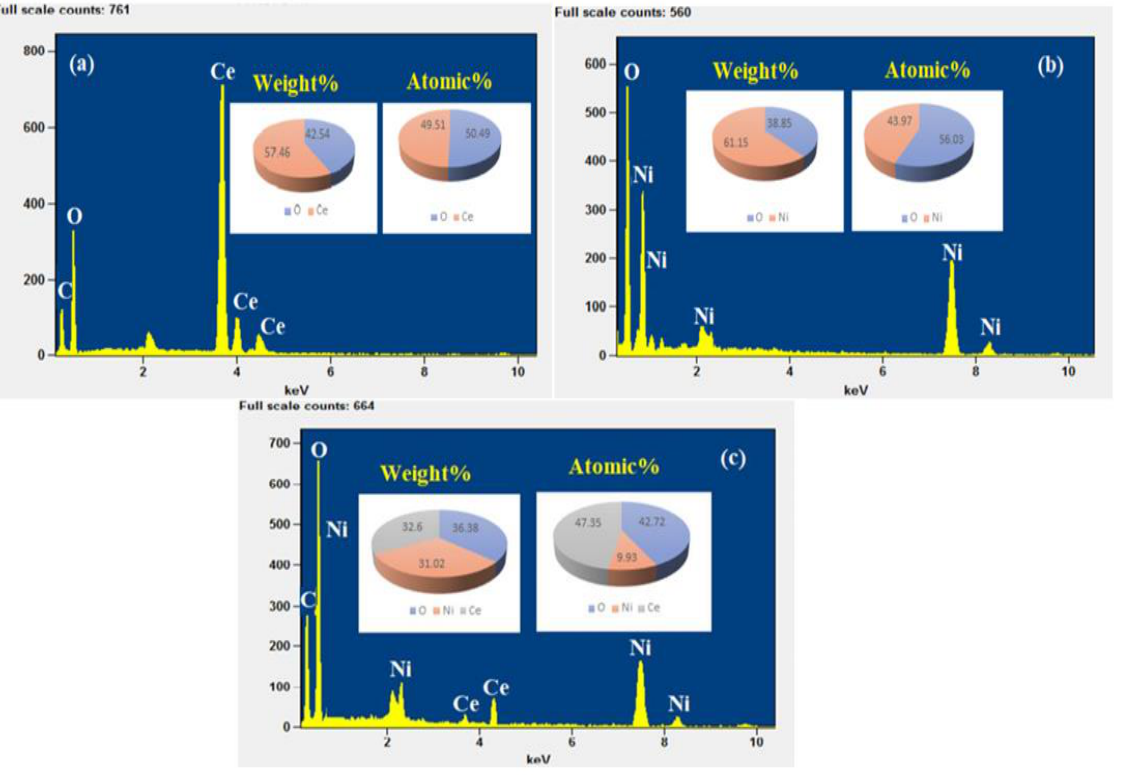
Figure 5. EDX spectra of ( a ) CeO 2 NPs (wheat husk extract) and ( b ) NiONPs (rice husk extract) and ( c ) their CeO 2 /NiO nanocomposite.